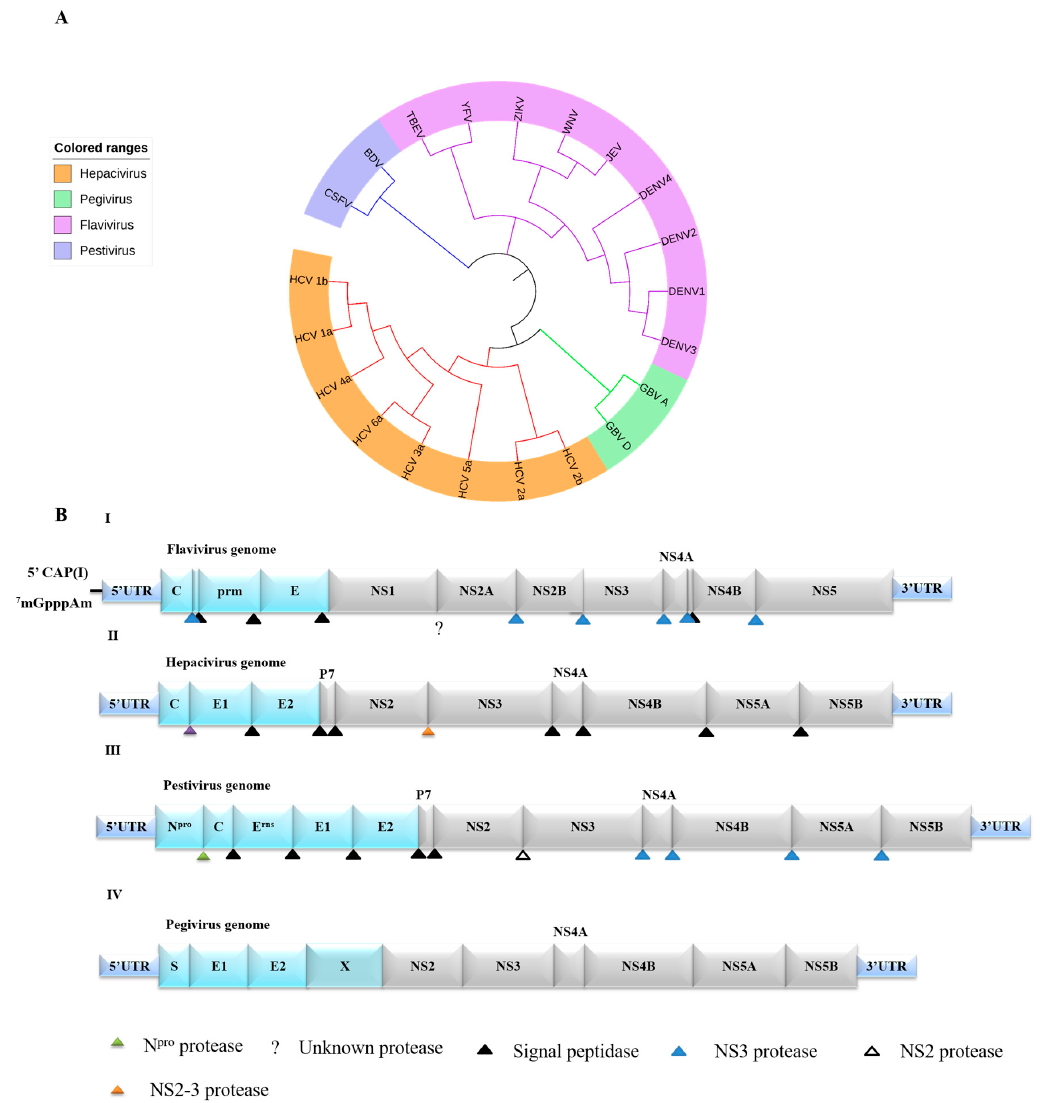
Figure 1. Flaviviridae phylogenetic characteristics and basic features of Flaviviridae reference genomes. ( A ) Flaviviridae family tree. Viruses related to this review and other representative Flaviviridae viruses; ( B ) The viral genome is shown in a schematic representation with a single long ORF (open reading frame) encoding the polyprotein, which is flanked by a 5 ′ -terminal non-coding region (NCR) and a 3 ′ -terminal NCR. The amino terminus of the genome encodes 3~5 structural proteins that form the virus particle and 7 non-structural (NS) proteins. Light blue and grey bars represent the structural and NS proteins, respectively. Cleavage sites for signal peptidase (black triangle), NS3 protease (blue triangle), unknown protease (?), NS2 protease (white triangle), N pro protease (green triangle), and NS2-3 protease (yellow triangle) are indicated.